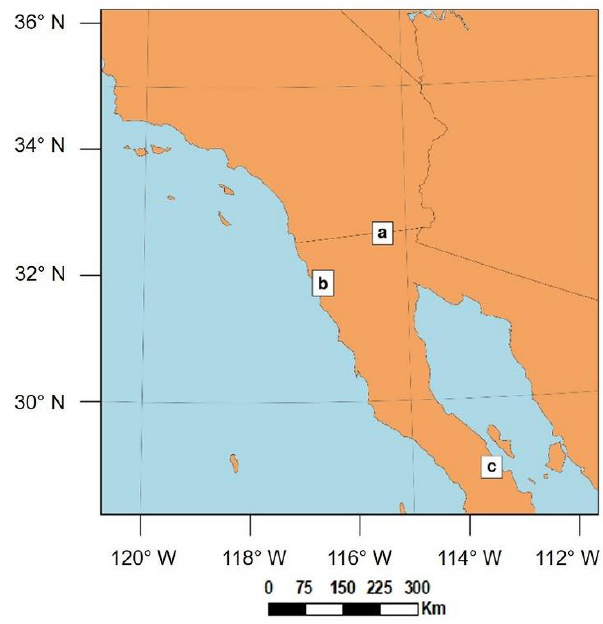
Figure3. DomainConfiguration. Nearestmeteorologicalstationsarealsoplotted: Ensenada( a )Mexicali ( b ) and Bah í a de los Á ngeles ( c Figure 3. Domain Configuration. Nearest meteorological stations are also plotted: Ensenada (a) Mexicali (b) and Bahía de los Á ngeles (c).